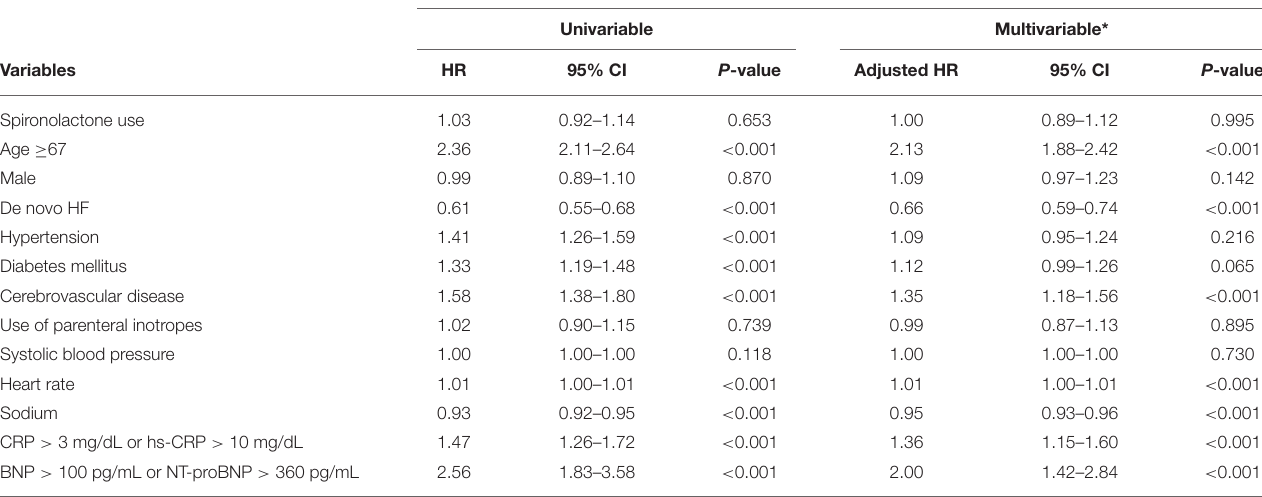
* All variables shown in table were entered into the multivariable Cox proportional hazard regression model. BNP, brain natriuretic peptide; CI,confidence interval; CRP, C-reactive protein; HF, heart failure; HR, hazard ratio; hs-CRP, high-sensitivity C-reactive protein; LVEF, left ventricular ejection fraction; NT-proBNP, N-terminal pro-brain natriuretic